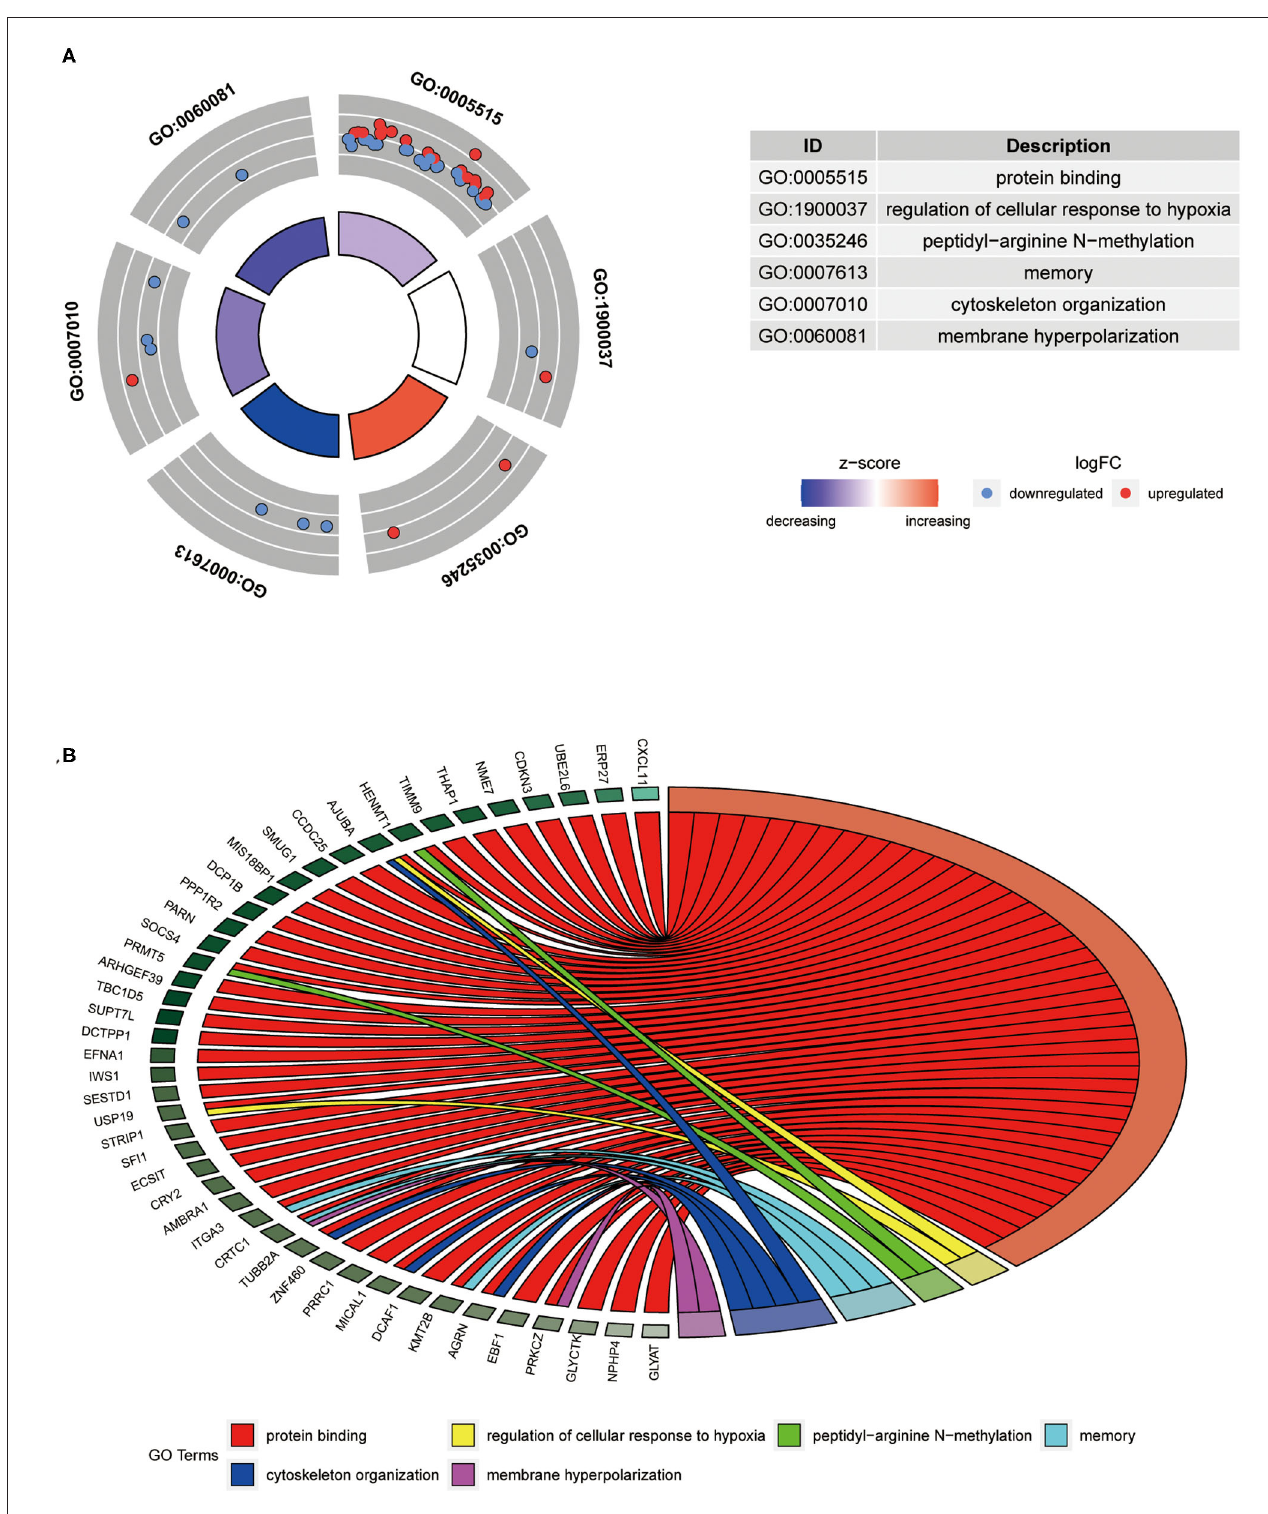
FIGURE 3 | Composition and differentially expressed genes of 41-GPS. (A) Gene enrichment distribution map. The picture shows the six most significant enrichment pathways (p < 0.05). Dots represent the gene symbol, red denotes upregulated gene, and blue denotes downregulated genes. The color of the enrichment pathway indicates the size of the z-score. (B) The specific distribution of gene enrichment. Different colors represent different access pathways.